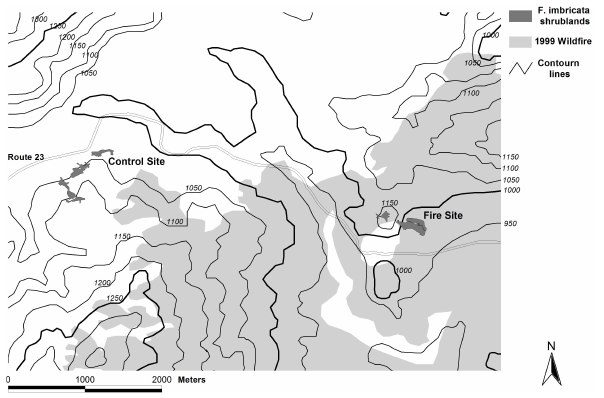
Fig. 3. Map of the area under study. This figure shows the mapped shrublands, the area damaged by the fire of 1999, as well as the topography of both sampling sites.